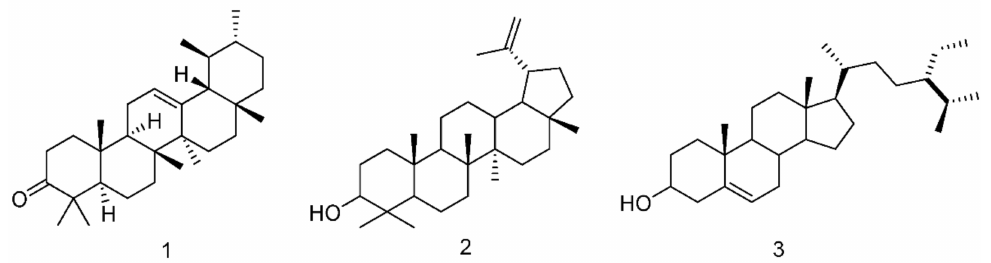
Figure 9. Chemical structure of α -amyrenone ( 1 ), lupeol ( 2 ), β -sitosterol ( 3